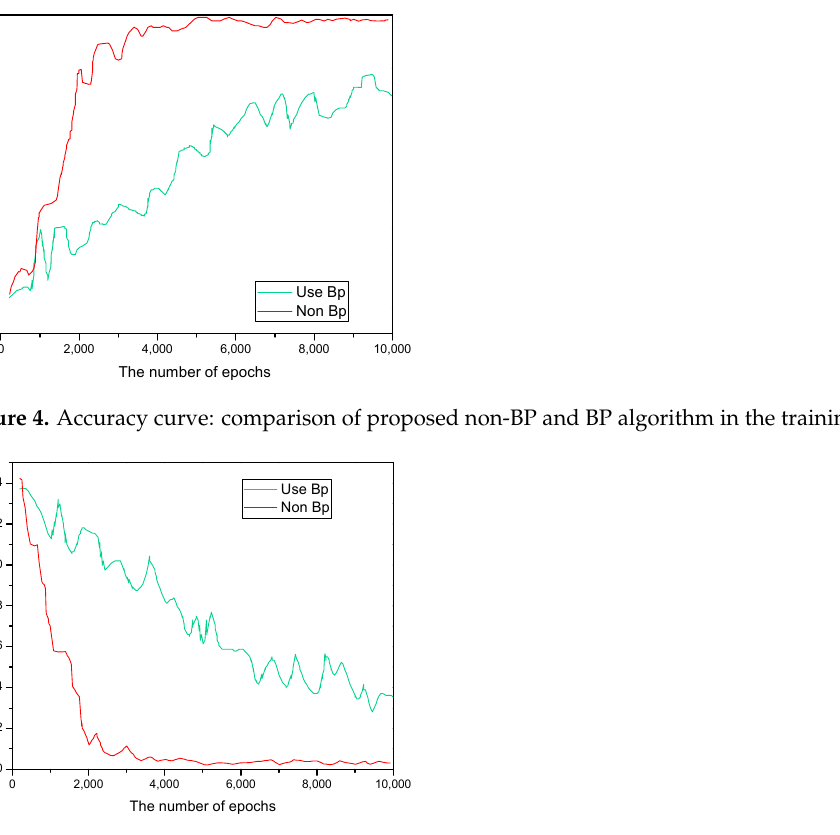
Figure 5. Loss curve: comparison of proposed non-BP and BP algorithm in the training process.